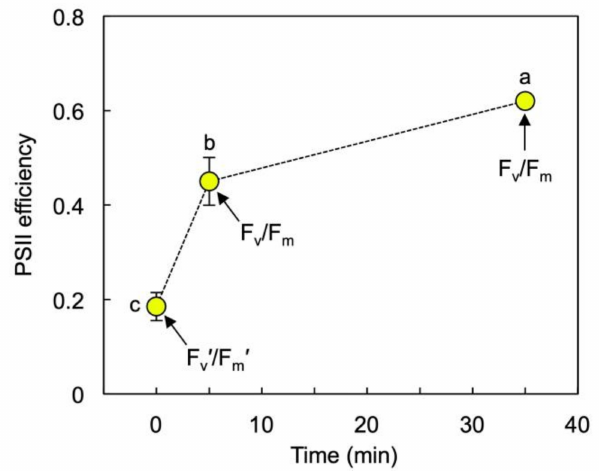
Figure 7. F v (cid:48) /F m (cid:48) (as an estimate of intrinsic PSII efficiency during exposure to growth PFD) and F v /F m (as an estimate of intrinsic PSII efficiency after 5 min darkness) for L. gibba fronds grown under 1000 µ mol photons m − 2 s − 1 . F v /F m was determined at two time points (i.e., after 5 min of darkness upon removal from growth PFD and following a recovery period of 30 min under 10 µ mol photons m − 2 s − 1 followed by 5 min darkness). Mean values ± standard deviations; n = 3. Significant differences between time points are denoted by different lower-case